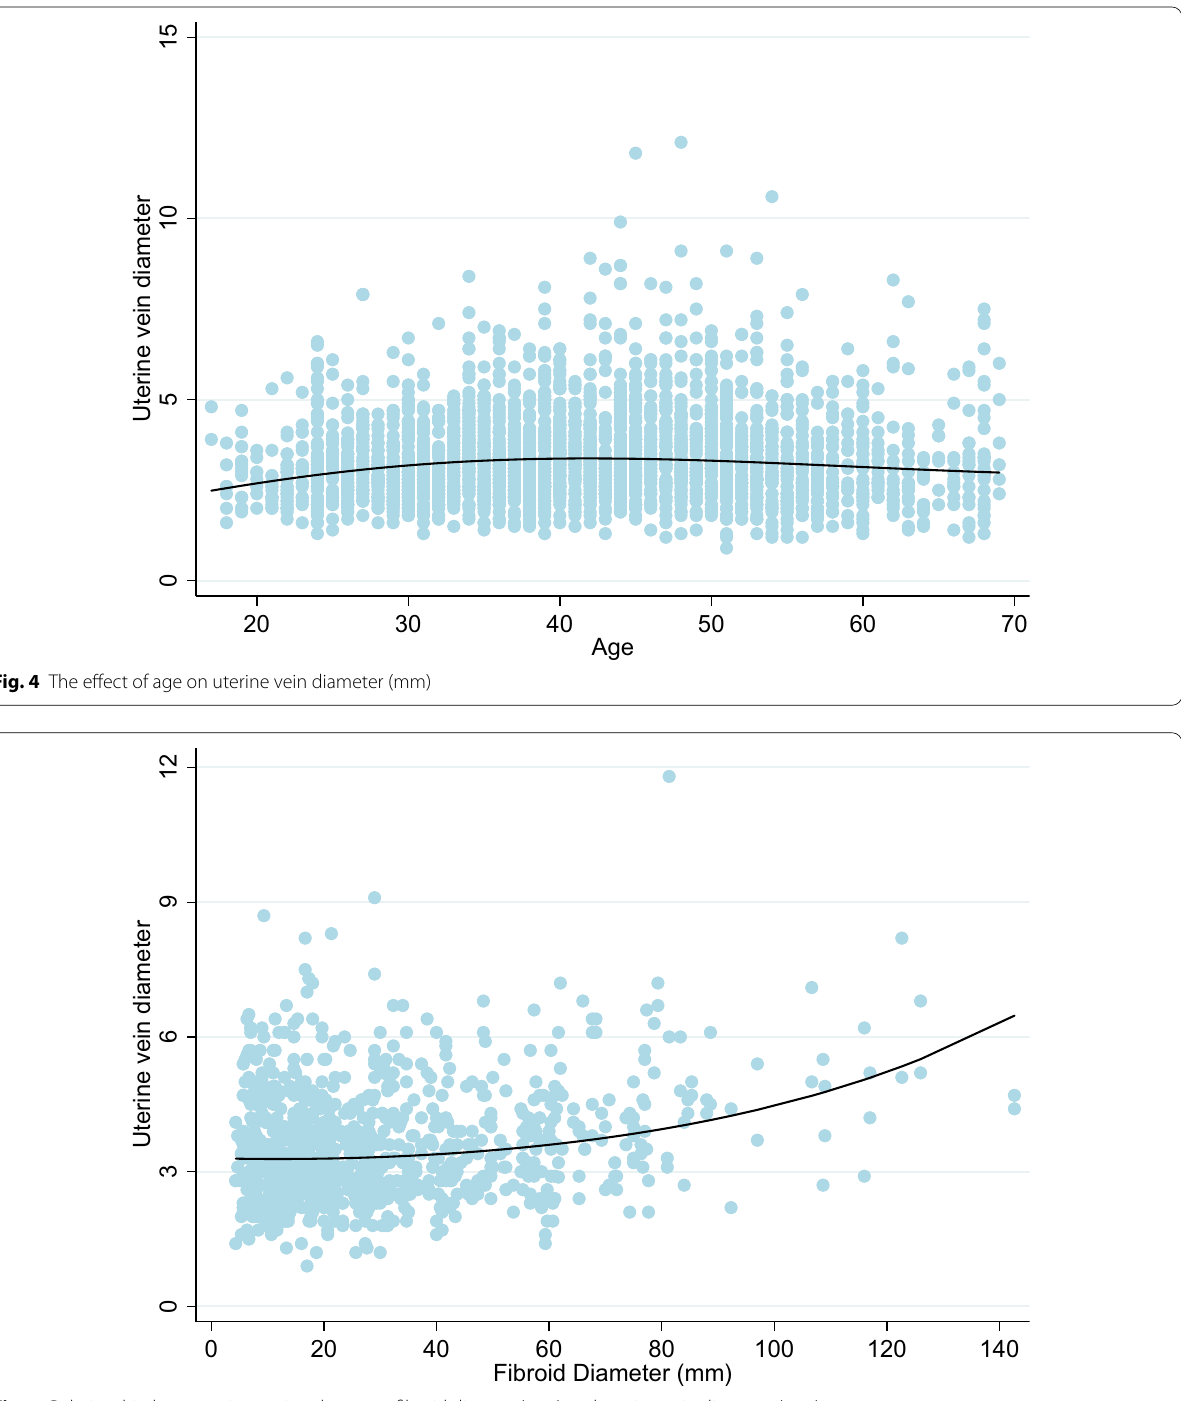
Fig. 5 Relationship between increasing the mean fibroid dimeter (mm) and uterine vein diameter